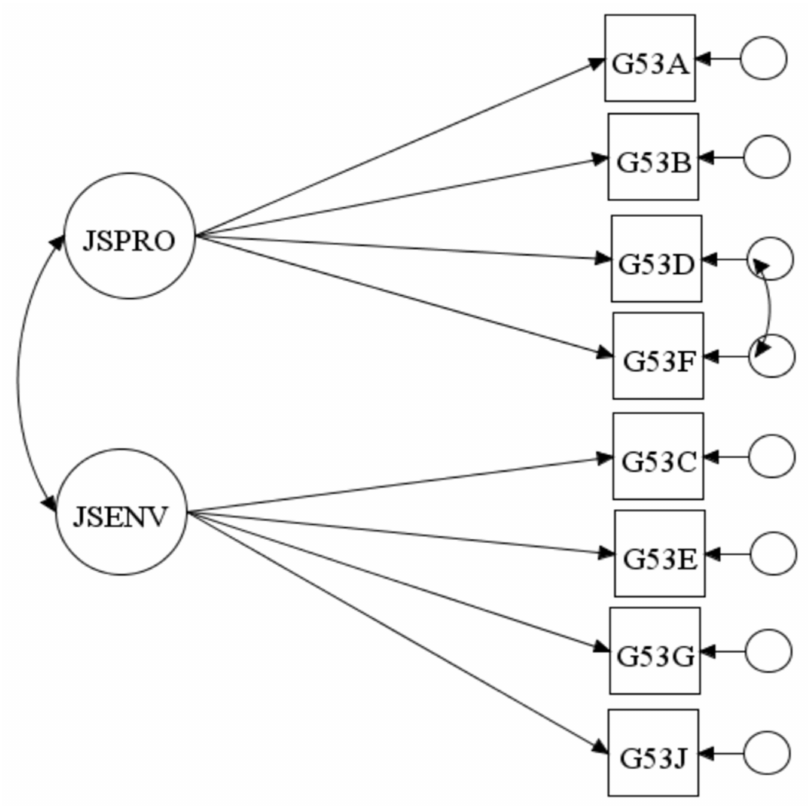
Figure 1. The first measurement model of the two-factor teacher job satisfaction